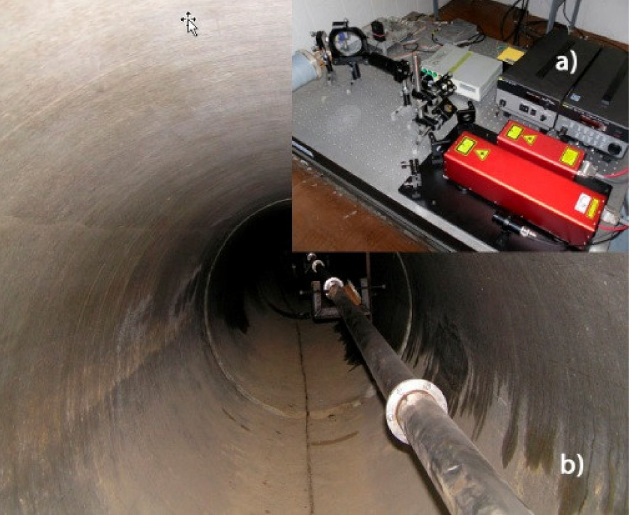
Figure 1. Shows photographs of the main interference unit of 52.5 m laser strainmeter ( a ) and an underground vacuum pipeline ( b